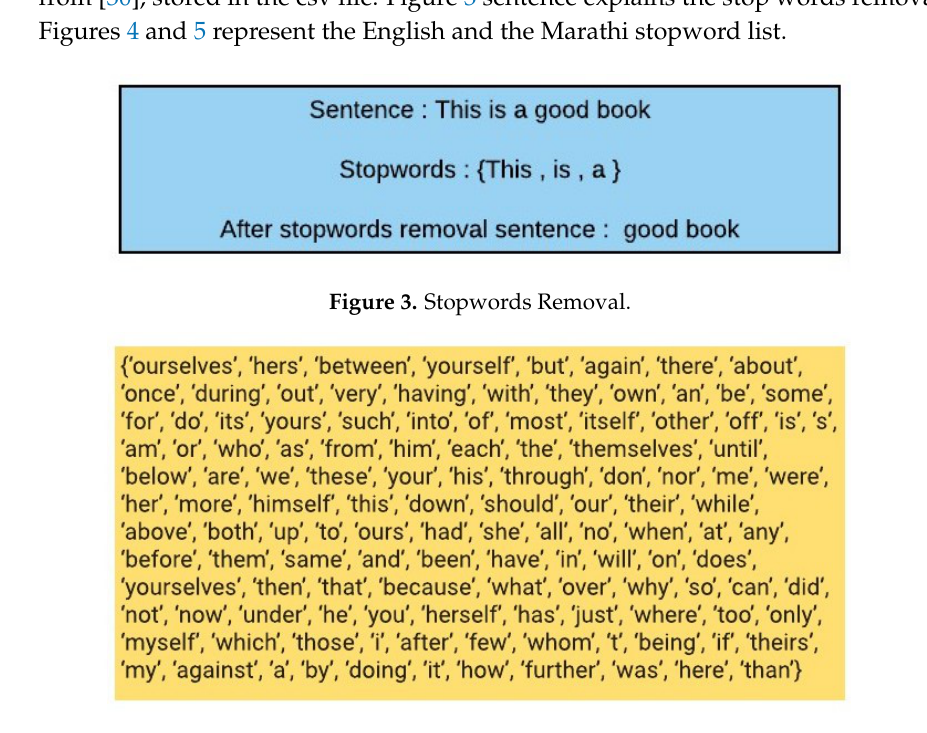
Figure 3. Stopwords Removal.